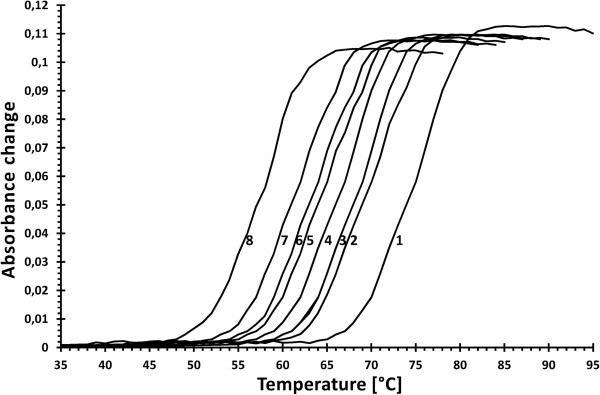
Melting profiles of dsDNA and its complexes with SSB proteins. A 0.67 nmol sample of duplex DNA (44 bp) was incubated alone (1) and with 4 nmol of the DpsSSB (2), FpsSSB and PinSSB (3), ParSSB (4), PprSSB(5), PcrSSB (6), EcoSSB (7) and PtoSSB (8), in a standard buffer containing 0.1 NaCl. Absorbance changes were measured at 260 nm.